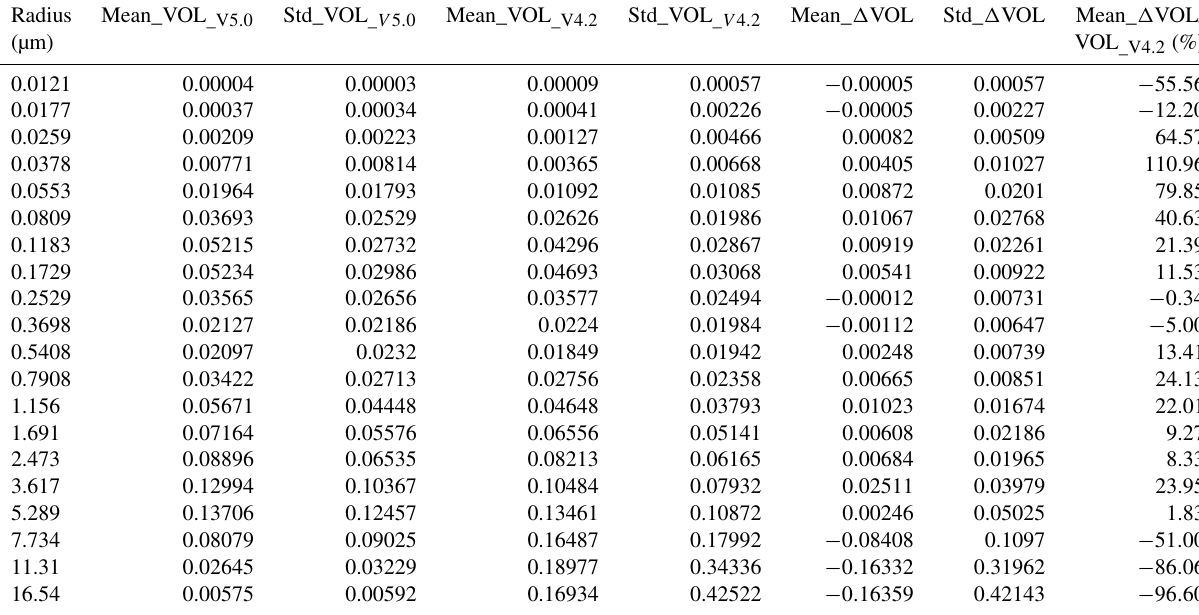
Meanings of all symbols are the same as in Table 1.